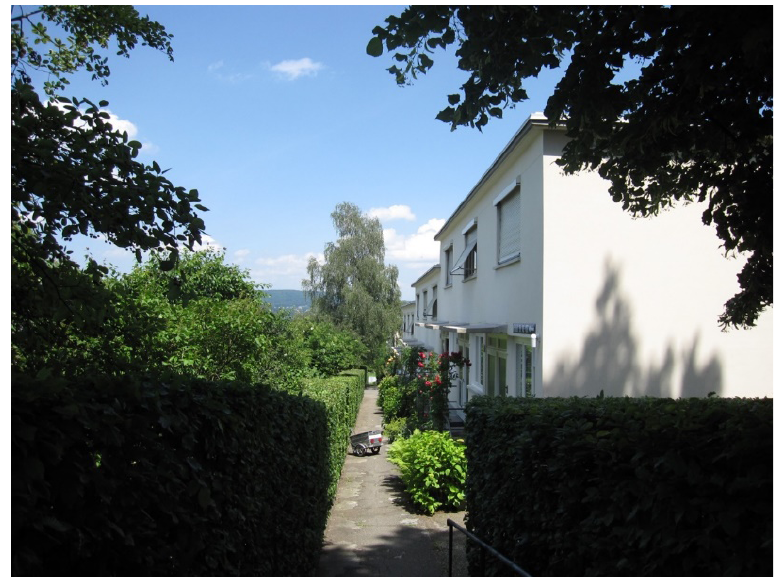
Figure 3. Neubühl housing settlement, Zurich, 1931, by Swiss CIAM architects. View of a row of minimum housing units, looking toward Lake Zurich. Source: Mumford